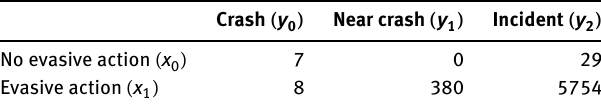
Table 1: Drivers of the following vehicles: dichotomous evasive